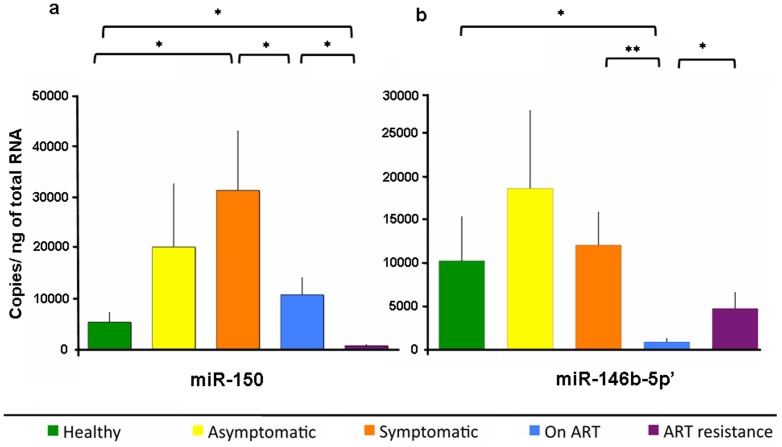
Absolute quantification of miRNAs in plasma.The levels of (a) miR-150 and (b) miR-146b-5p in different groups of HIV/AIDS patients and healthy controls by qRT-PCR are shown. The graph indicates the number of copies/ng of total plasma RNA. The error bar of each group represents mean ± SEM and asterisks denote statistically significant differences (** p<0.01, * p<0.05) for the indicated groups (Student's T test).